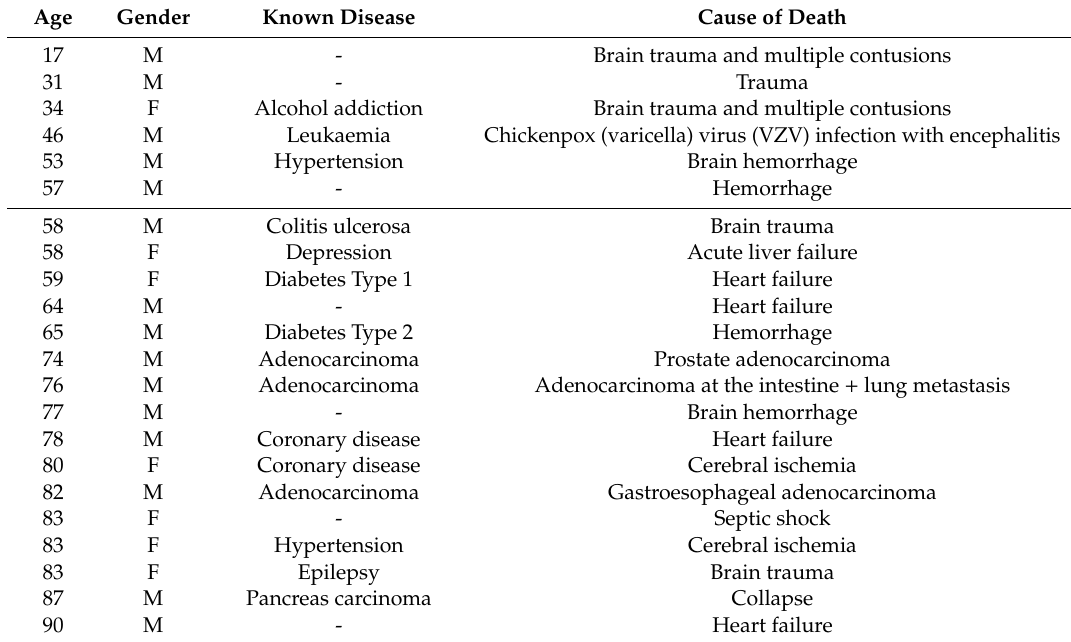
Table 1. Human donor